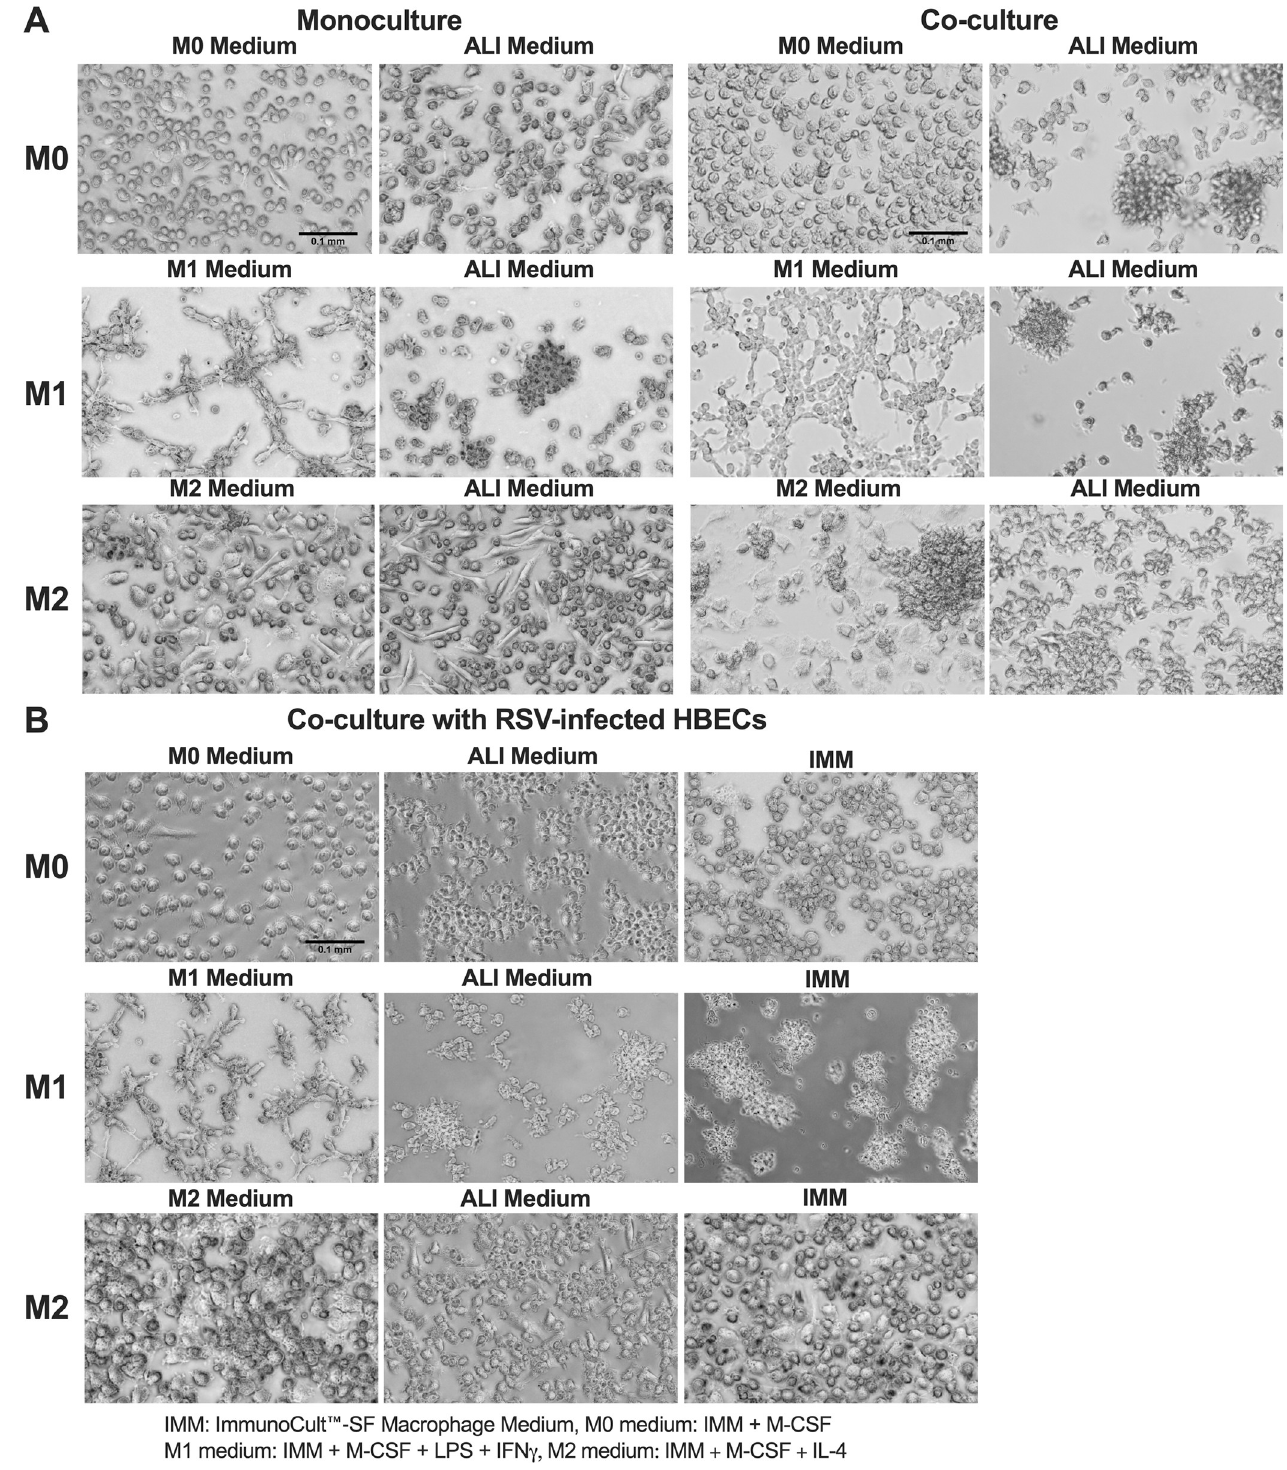
Fig 2. Morphology of M0, M1, or M2 macrophages after culture. (A) M0, M1, or M2 macrophages were placed in either M0, M1, or M2 medium (respectively) or ALI medium as either monoculture or co-culture with HBECs for 72 hours and white light images taken to assess morphology. (B) M0, M1, or M2 macrophages were placed in either M0, M1, or M2 medium (respectively), ALI medium, or IMM as co-culture with RSV-infected HBECs. Images were taken after 72 hours of co-culture with infected cells and are a representative image of n = 5. Scale bar represents 0.1 mm.